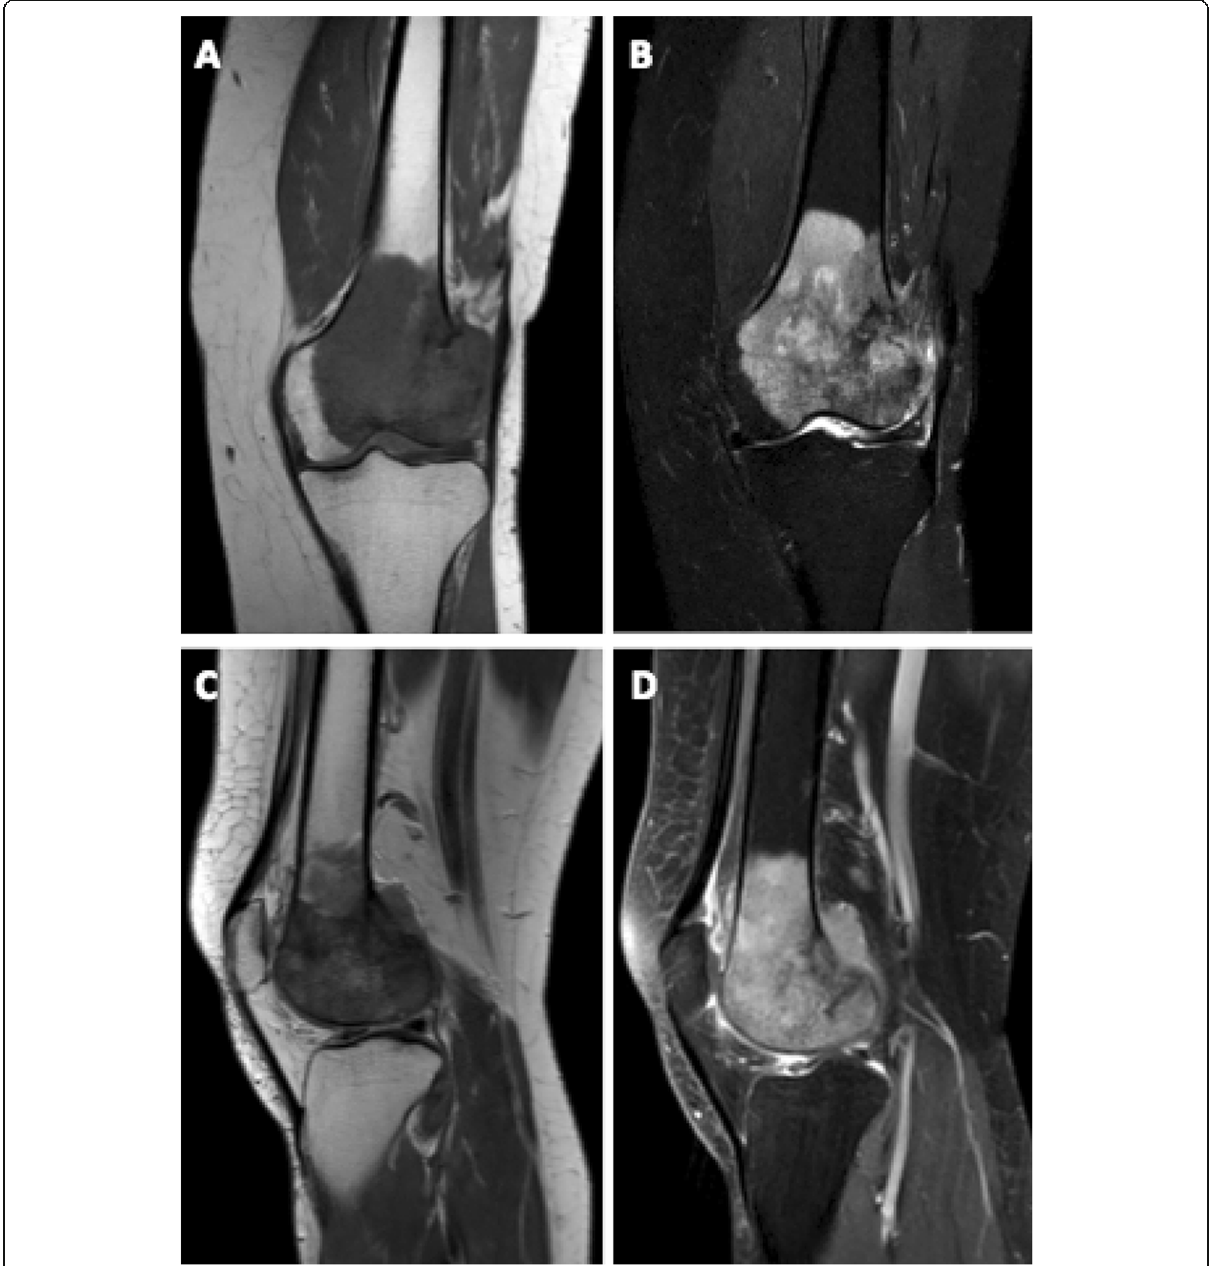
Further imaging was obtained including a